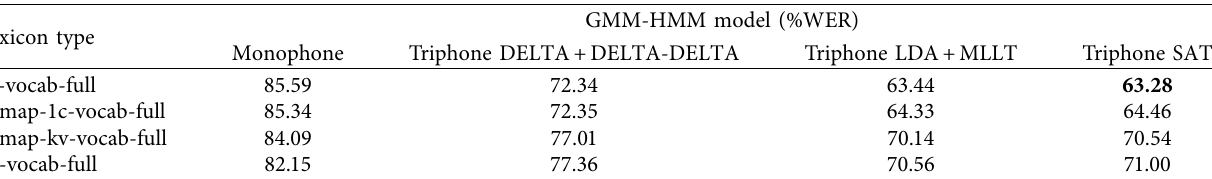
Table 11: The performance of the acoustic models using 30,000 unvalidated utterances. Lexicon